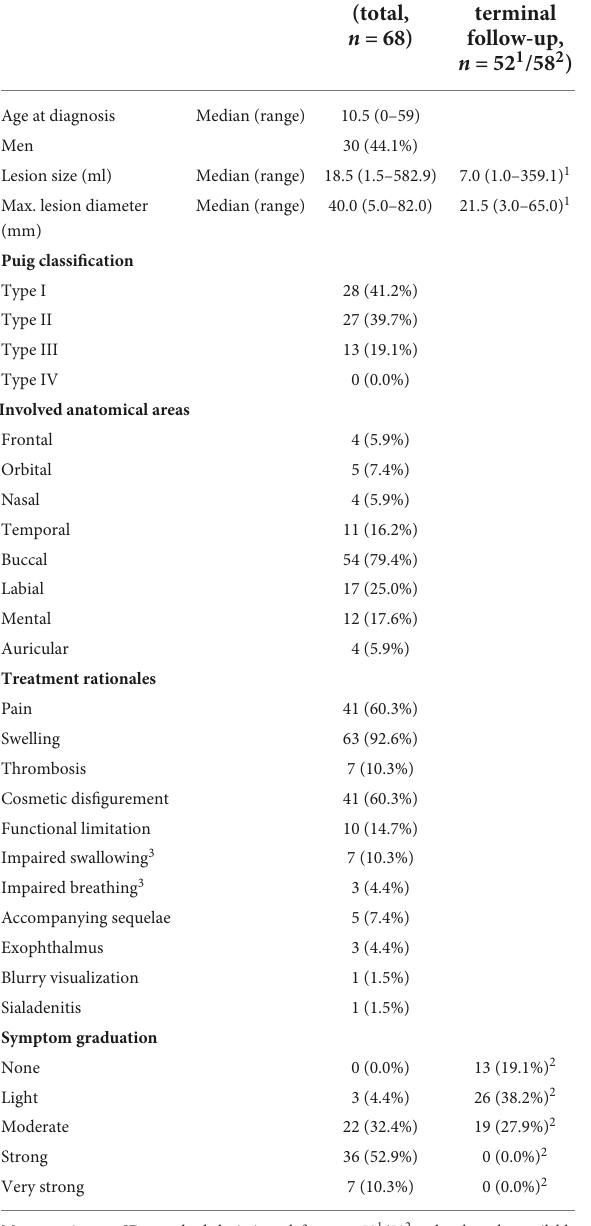
TABLE 1 Patient characteristics of the study cohort. TABLE 2 Procedural data of the study